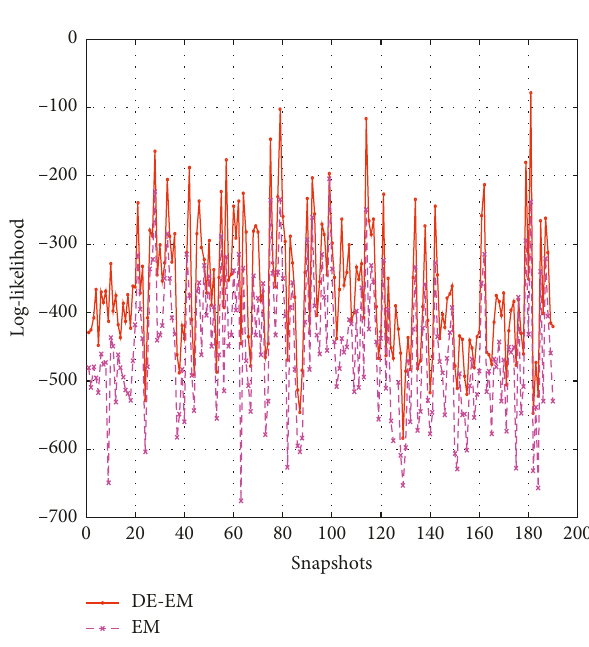
Figure 6: Log-likelihood in different